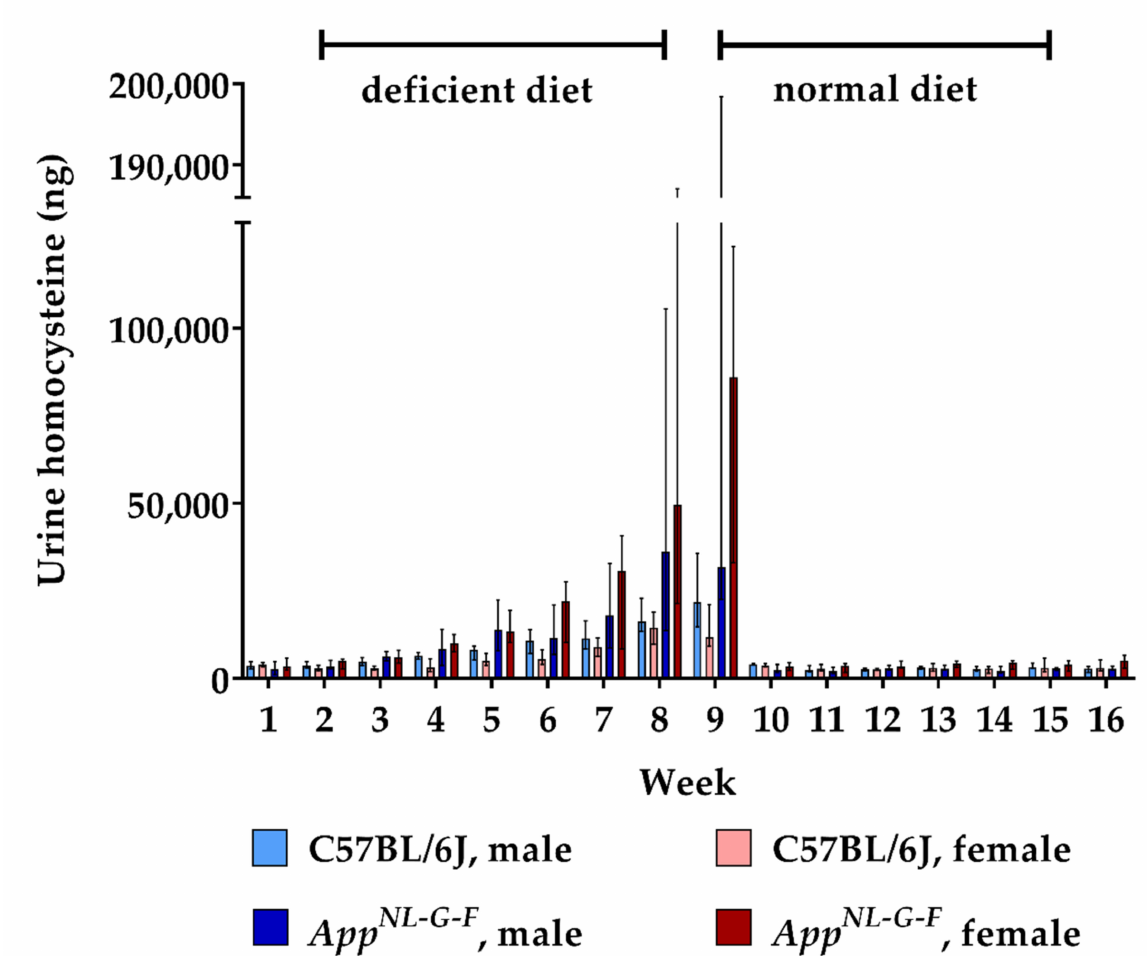
Figure 3. Urinary homocysteine levels in C57BL/6J wild type and App NL-G-F knock-in mice, data are depicted for males and females separately for experimental week 1-17: baseline measurement (w. 1), diet deficient in vitamin B6, B12 and folate (for 8 w.), balanced normal chow (for 8 w.); all urine samples were analyzed using a combination of liquid chromatography with tandem mass spectrometry and statistically tested non-parametrically using the Kruskal-Wallis test; data are presented as median ± interquartile range (IQR); extreme outliers beyond 3xIQR have been